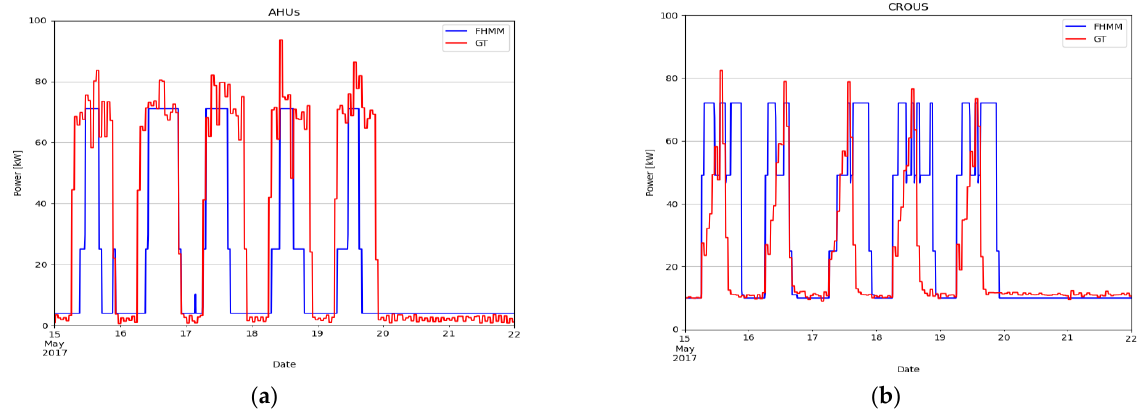
Figure 12. Disaggregation results following the application of the FHMM algorithm for the AHUs and Crous loads, ( a ) AHUs, ( b ) Crous.